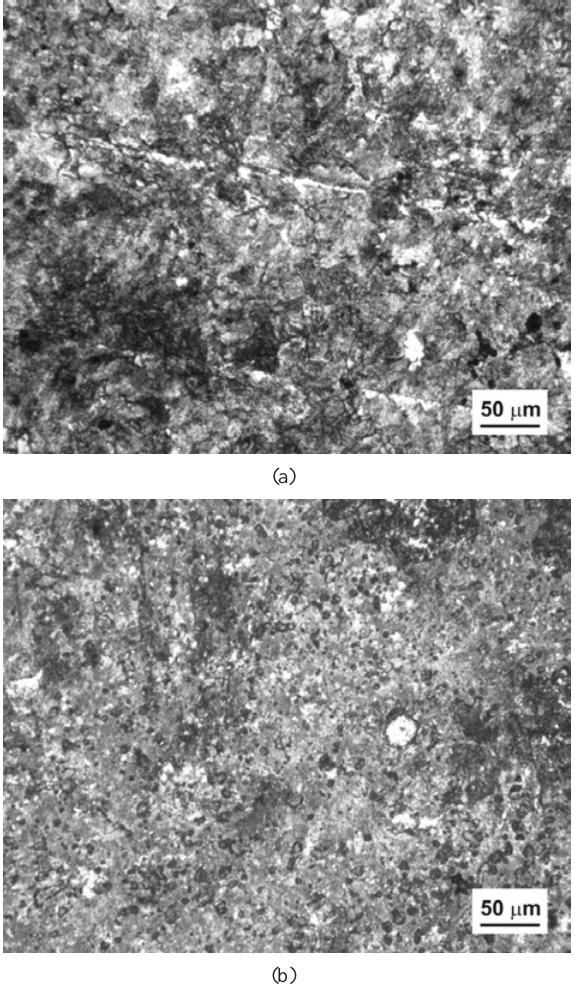
Figure 2. The microstructure cooled at 0.1 K = s (a) and at 0.235 K = s